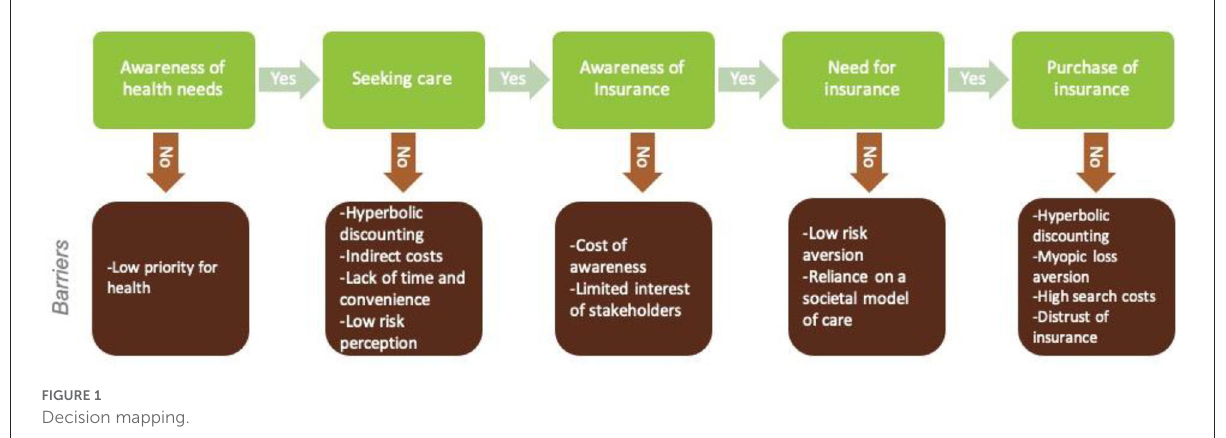
FIGURE1 Decision